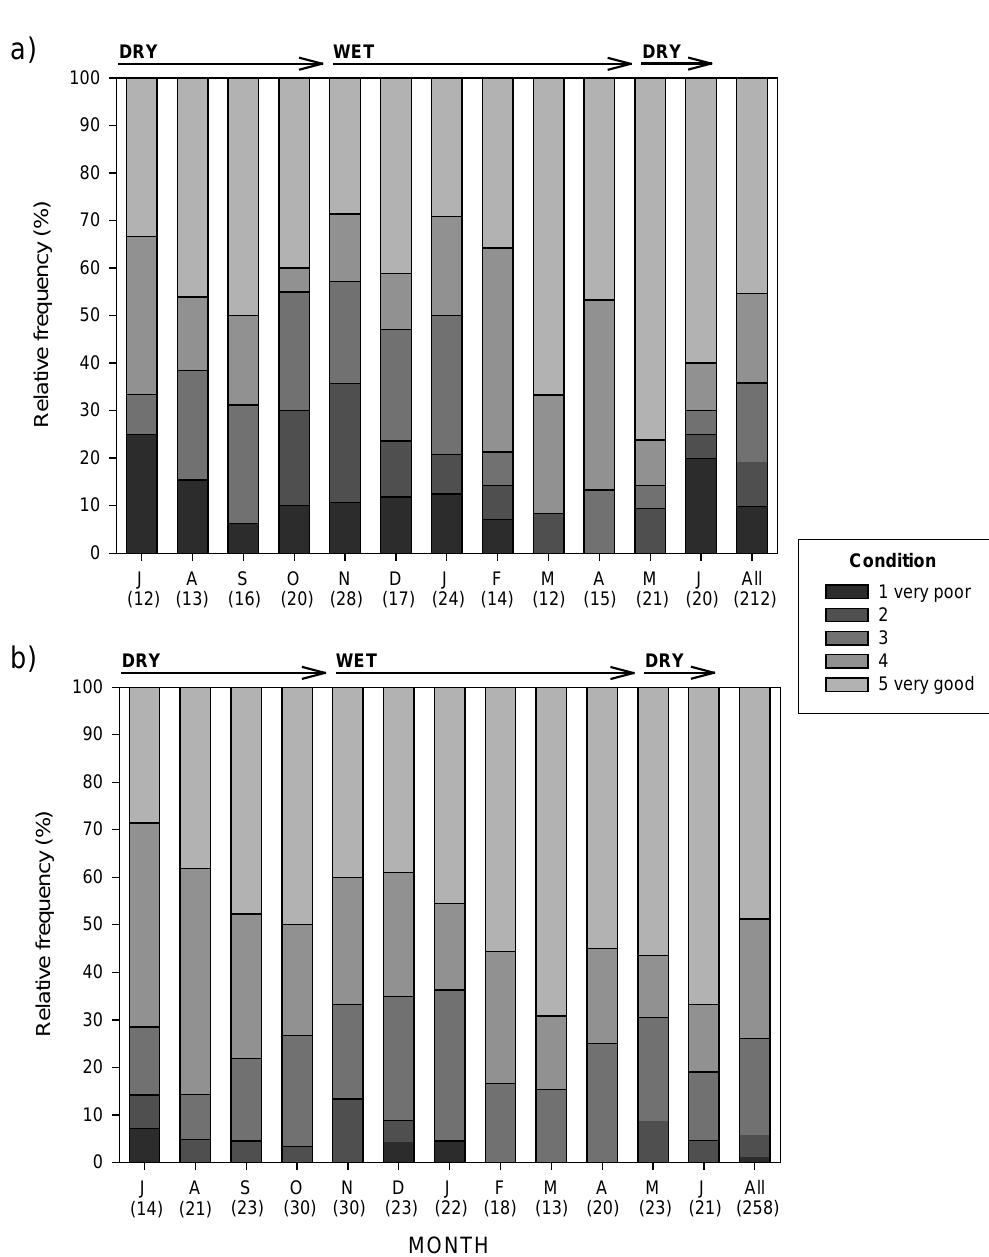
Figure 5. Relative frequency of monthly (July 1995–June 1996) and overall condition scores for ( a ) adult female and ( b ) adult male dogs, through dry and wet seasons. Numbers in brackets indicate the monthly or total sample sizes of records.